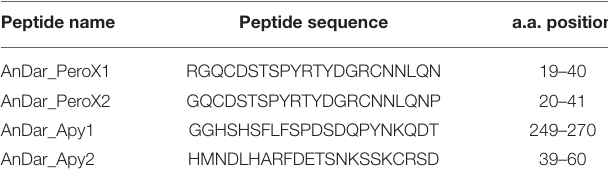
TABLE 3 | An. darlingi peptide sequences from the apyrase and the peroxidase/oxidase proteins identified by mass